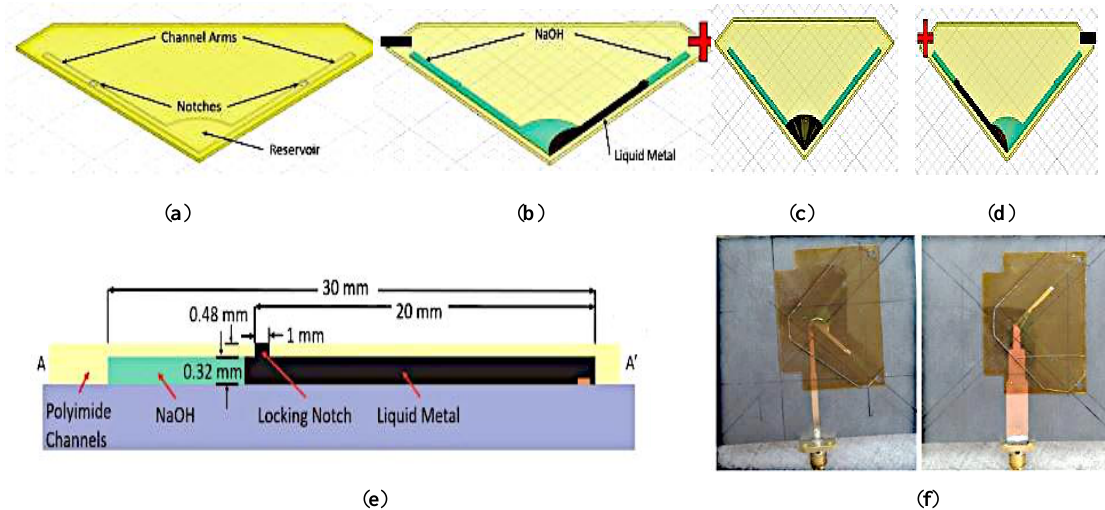
Figure 19. Liquid metal actuation within the fluidic channels for the antenna in [40]: ( a ) one-sided channel structure. ( b ) State 1 with liquid metal (black) and electrolyte solution (green) in the channels. ( c ) Withdrawing the liquid metal into reservoir. ( d ) Reversing the polarity to actuate the liquid metal into State 2. ( e ) The cross section of each arm structure. ( f ) Front and back of the assembled antenna.